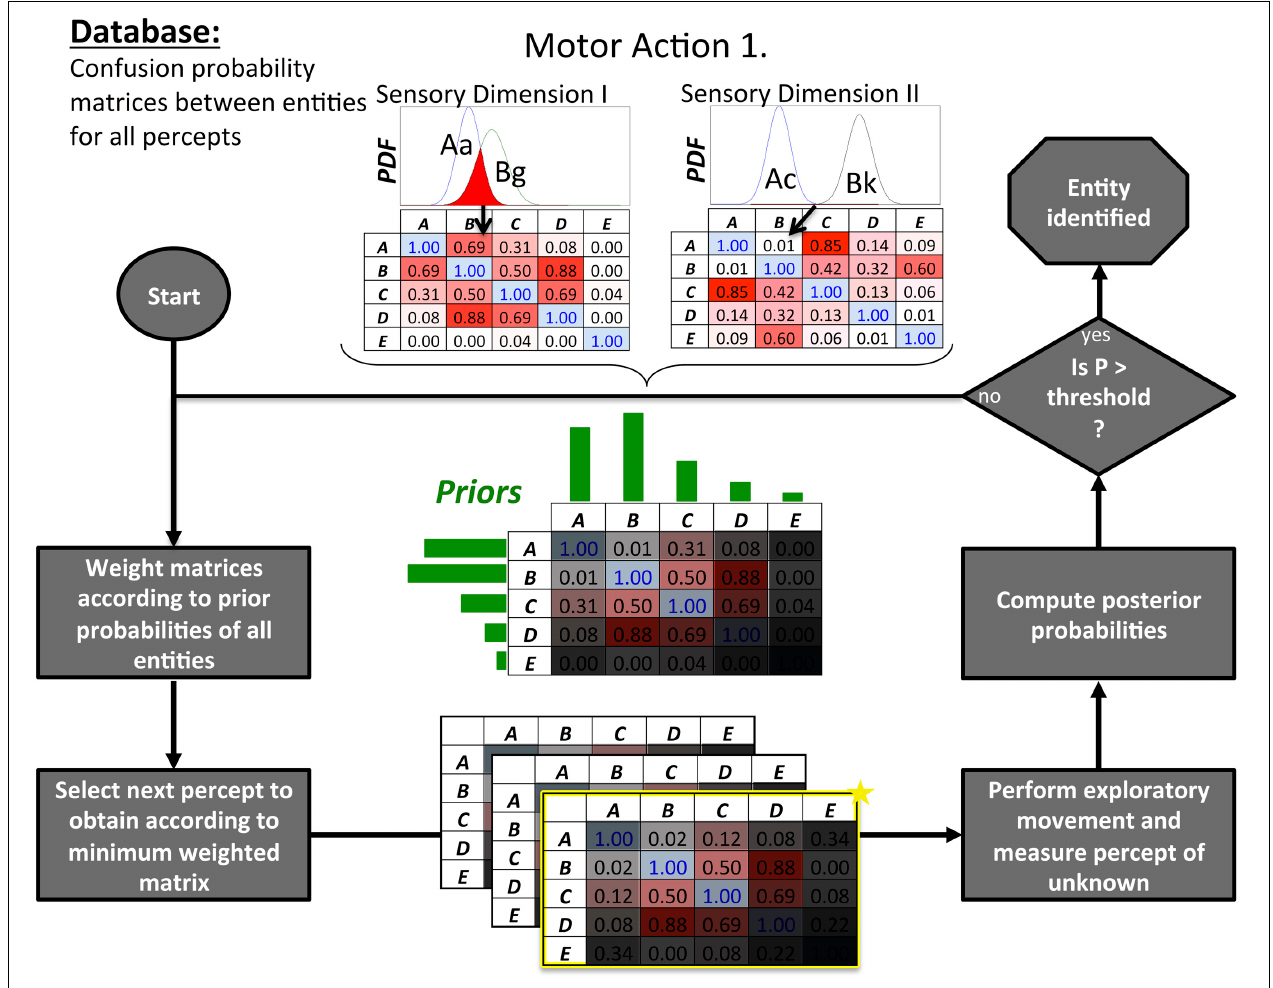
FIGURE 3 | Bayesian Exploration is used iteratively to identify an unknown entity by selecting and executing exploratory movements to disambiguate alternative hypotheses A–E. Prior experience with all candidate identities is stored in a database that permits extraction of confusion probability matrices (top center) that quantify the degree of overlap (red) in the probability density functions (PDF) of their sensory percepts (e.g.,